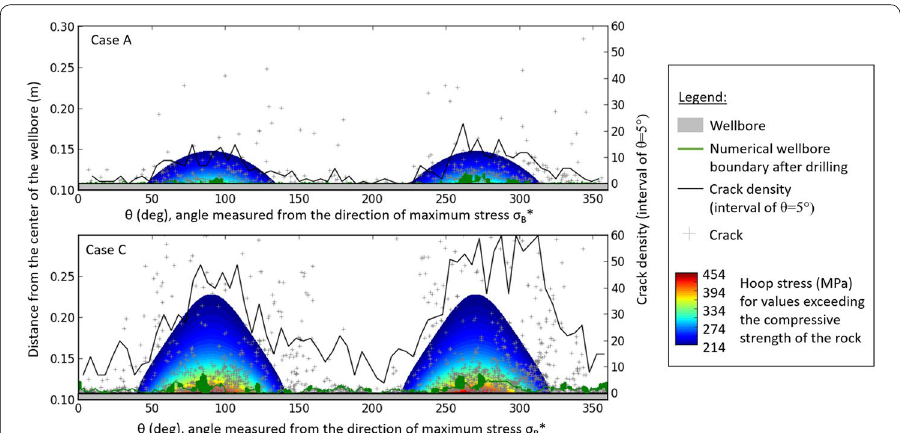
Fig. 11 Distance of the new wellbore boundary and of the cracks resulting from numerical simulations of drilling, and crack density within an interval of 5° for the stress states A and C in plot vs. the angle measured from the maximum stress direction θ. The colormap refers to area where the hoop stress exceeds the compressive strength according to the analytical